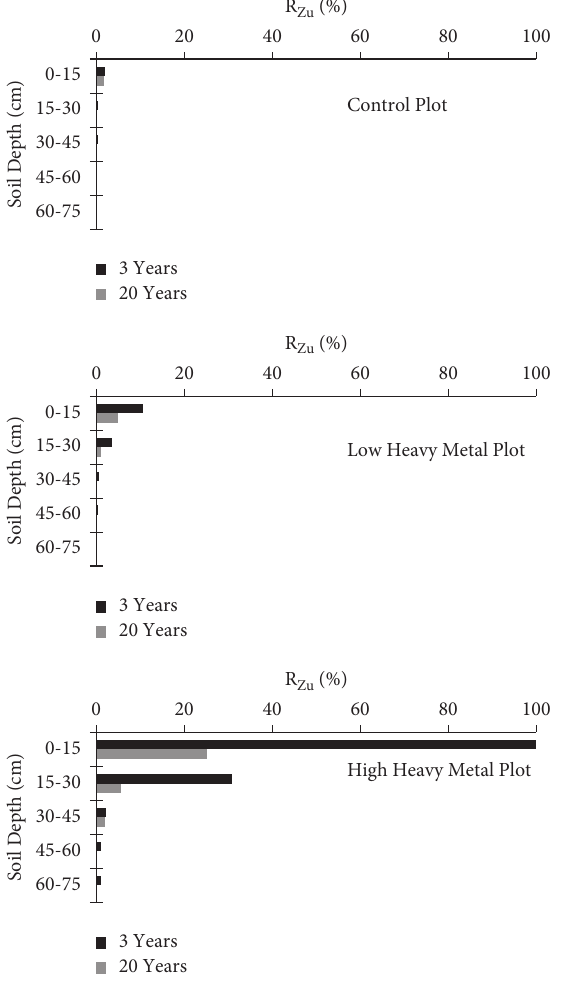
Figure 8: The vertical spatial distribution of soil Zn 3 years 1) and 20 years 2) after amendment with industrial waste (R Zn is the ratio of the actual concentration to the highest concentration of Zn in the 60 Mg waste ha − 1 plot (90.0 mg · kg − 1 ); waste at CP � 0, LMP � 15, and HMP � 60Mg waste ha − 1 ; 1) after [42]; 2) after Fernando and Salam (unpublished data 2018).